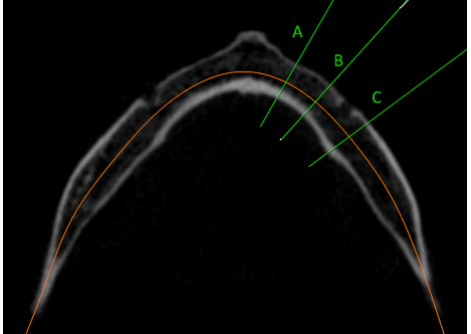
Figure 1. CBCT axial view of selected regions of the mandible: (A) lateral incisor region (9 mm from the midline of the mandible); (B) first premolar region (6 mm anteriorly from the middle of the mental foramen); (C) first molar region (6 mm distal from the middle of the mental foramen).